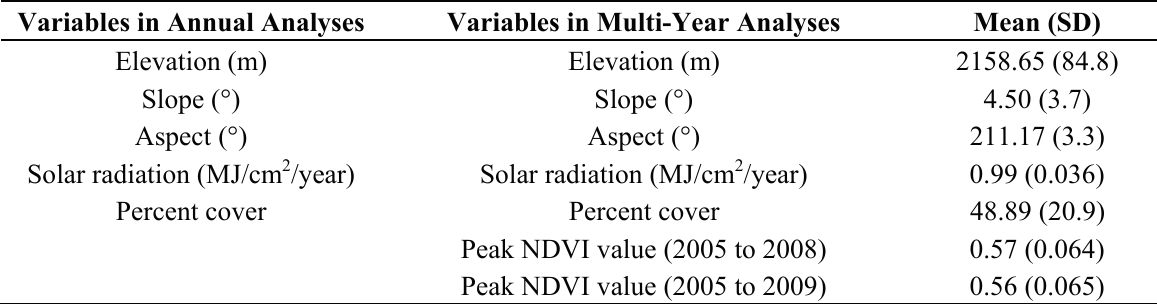
Table 1. Mean and standard deviation (SD) descriptive statistics of variables in the annual and interannual analyses of peak NDVI timing. Values are calculated from the 800 random points located within ponderosa pine STARFM pixels. Mean NDVI and coefficient of variation (CV) of NDVI are shown in Figure